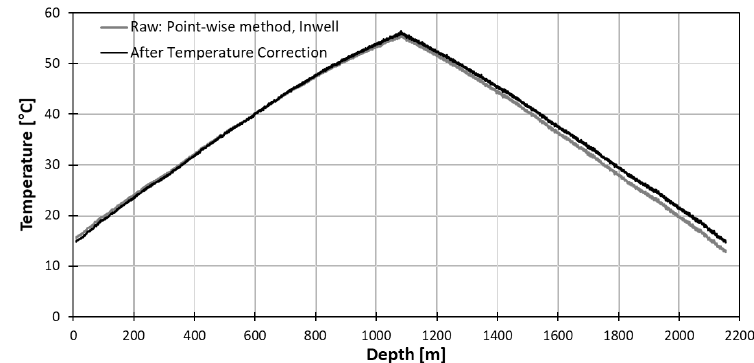
Figure 12. Temperature profile after correction by pointwise method with 10 m in-well diver.